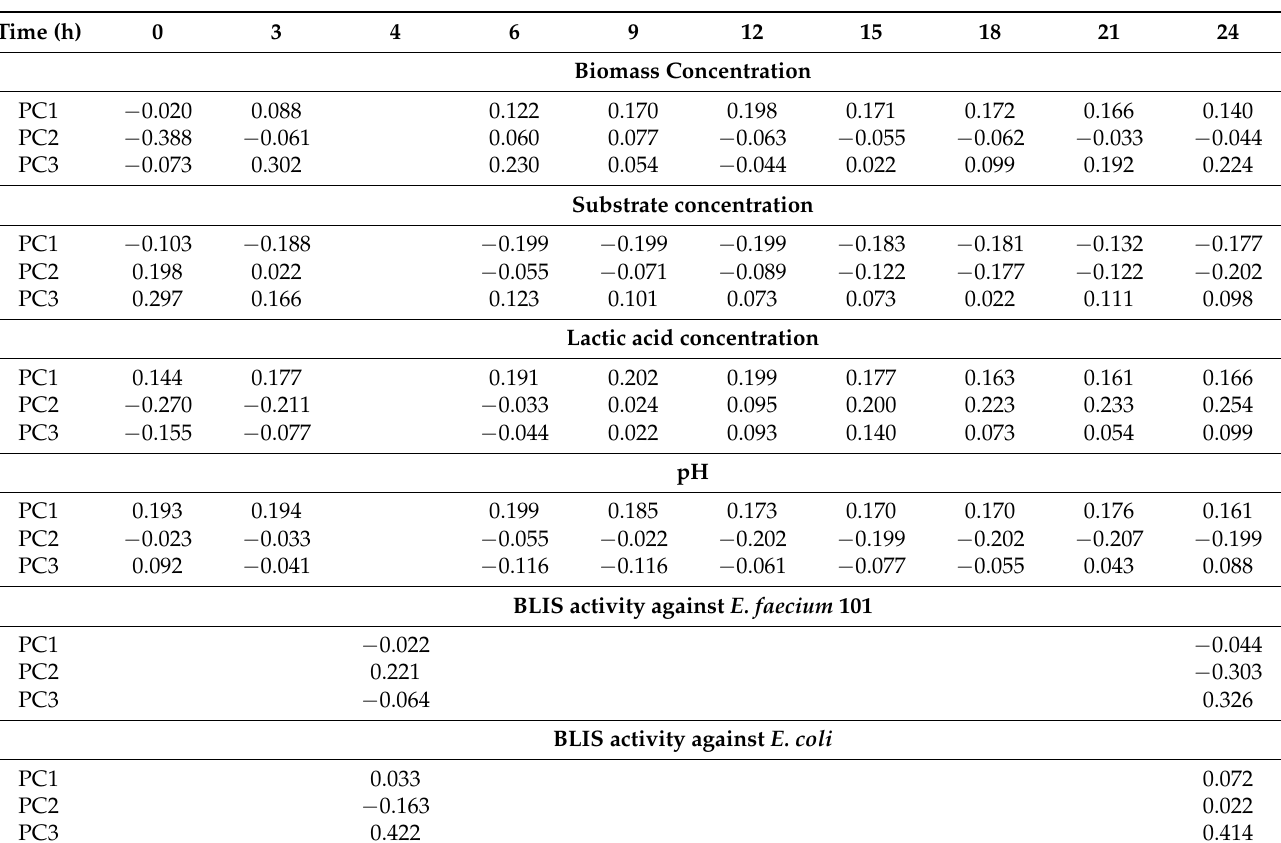
Table 4. Coefficients of Principal Component Analysis (PCA) applied to the three main components (PC1, PC2 and PC3) of P. pentosaceus fermentation in MRS